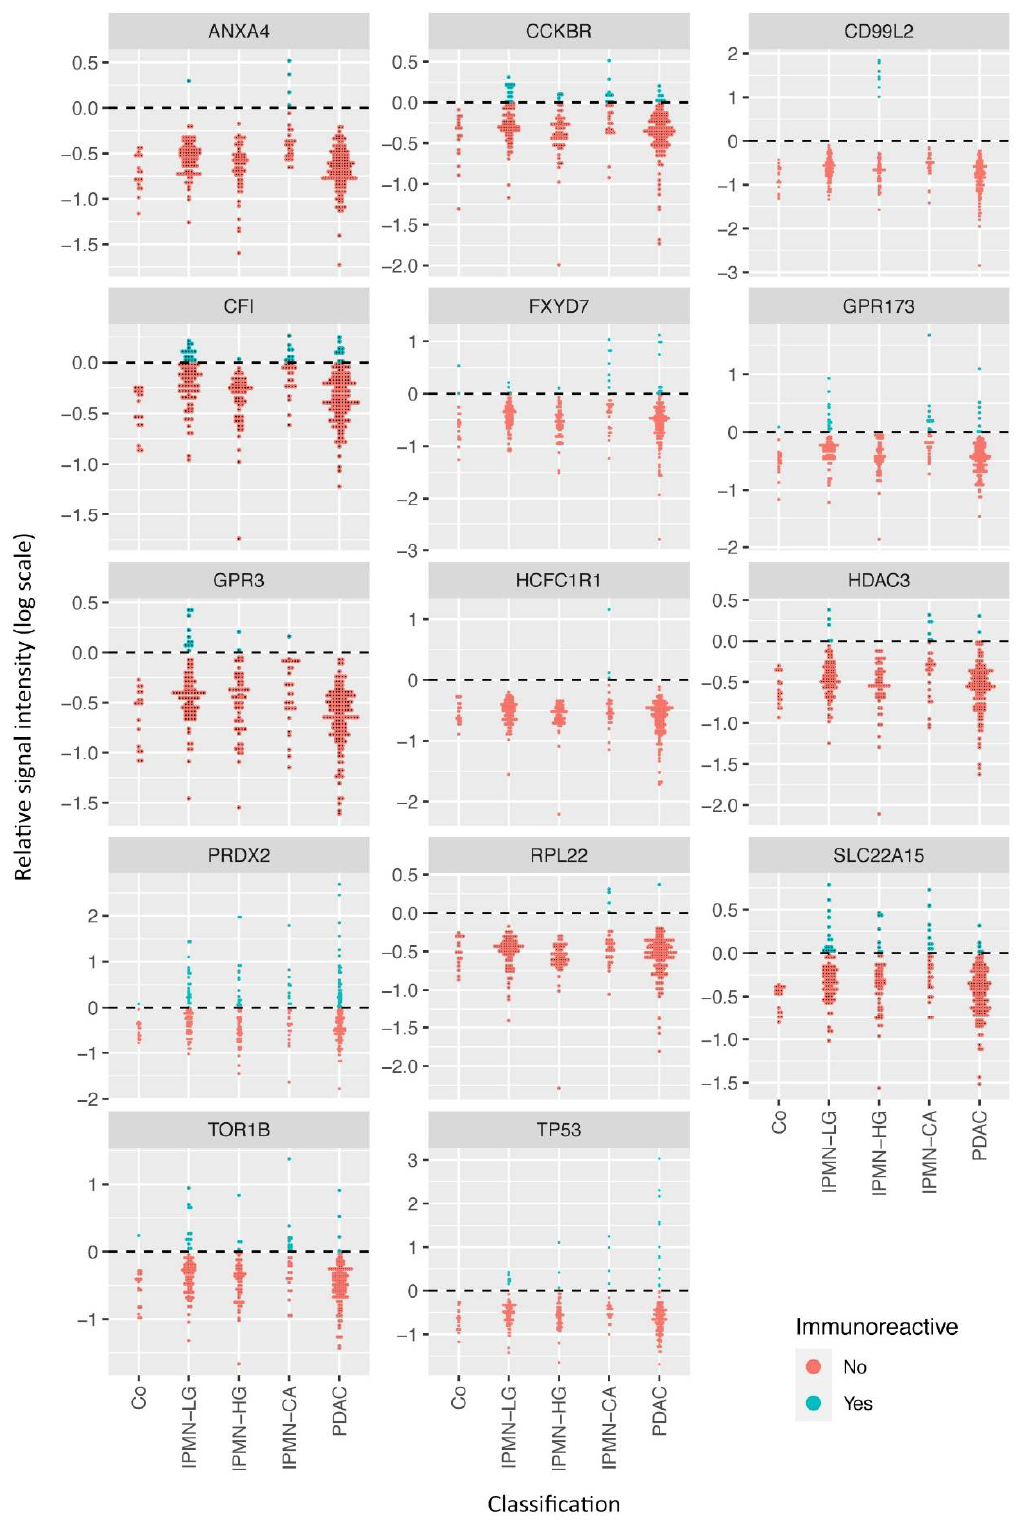
Figure 2. Relative signal intensities of the proteins selected for disease discrimination. The MFI values for the selected autoreactive antigens are shown after division by the thresholding value for positivity and on a logarithmic scale. Values above 0 (blue) are considered indicators of immunoreactivity.